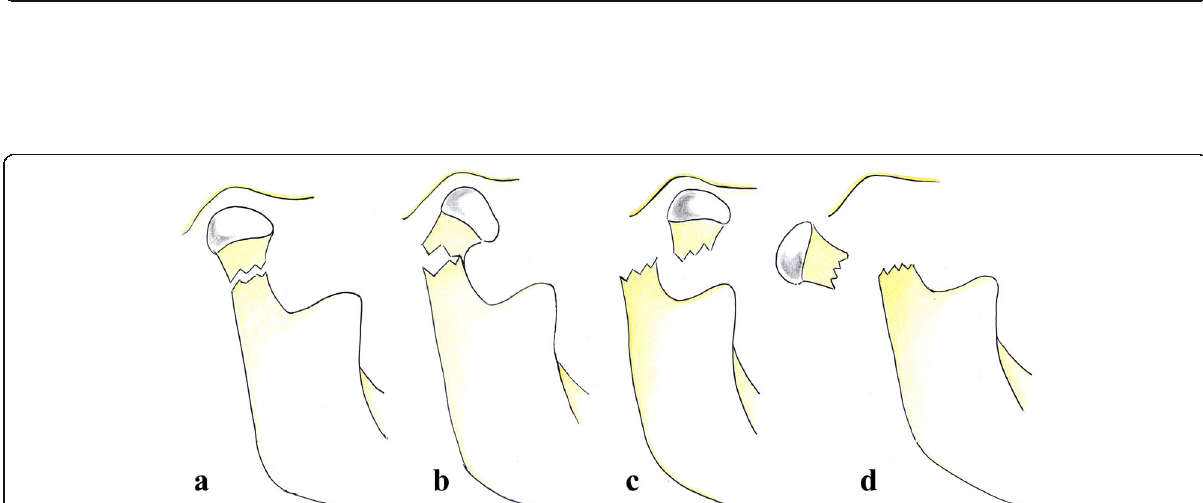
Fig. 12 Picture depicting mandibular condyle fractures in according with the AO Foundation ’ s classification. A fracture is considered “ high-neck ” and “ low-neck ” when it is above and below Line 4, respectively. A full description is provided in the main text